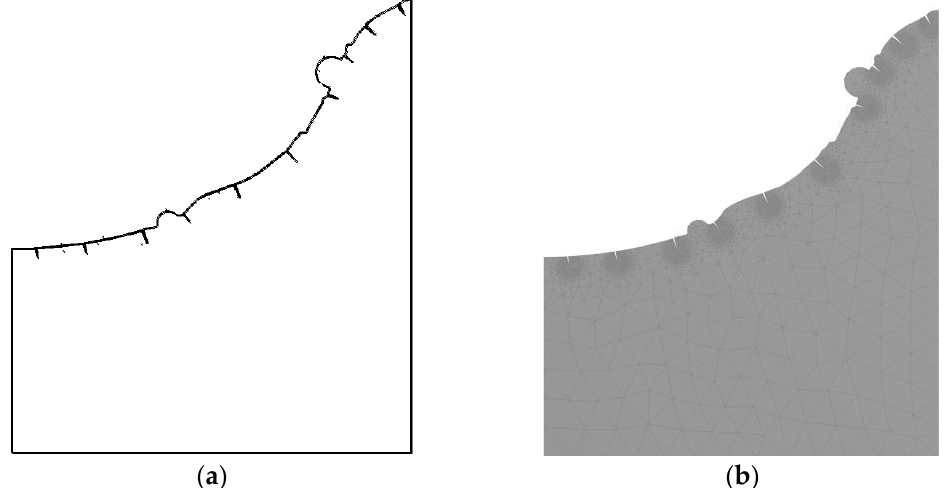
Figure 7. Geometric and meshed model of preset crack. ( a ) A geometric model of a preset crack; ( b ) meshed model.